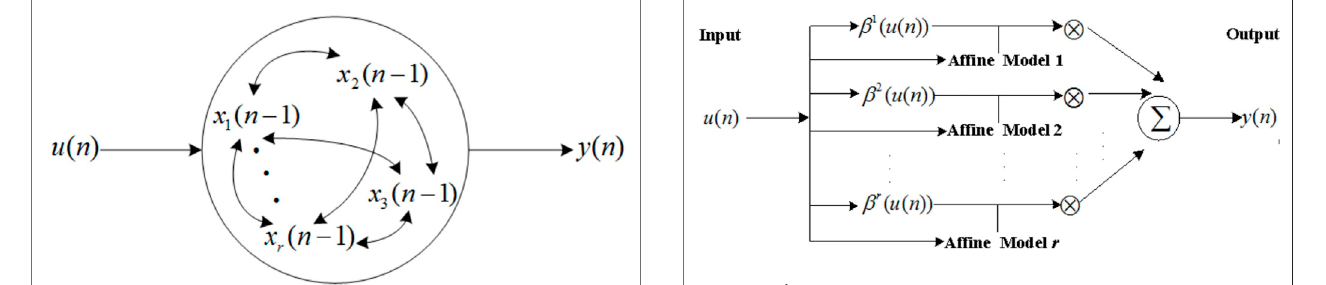
FIGURE 3 | Architecture of the TS